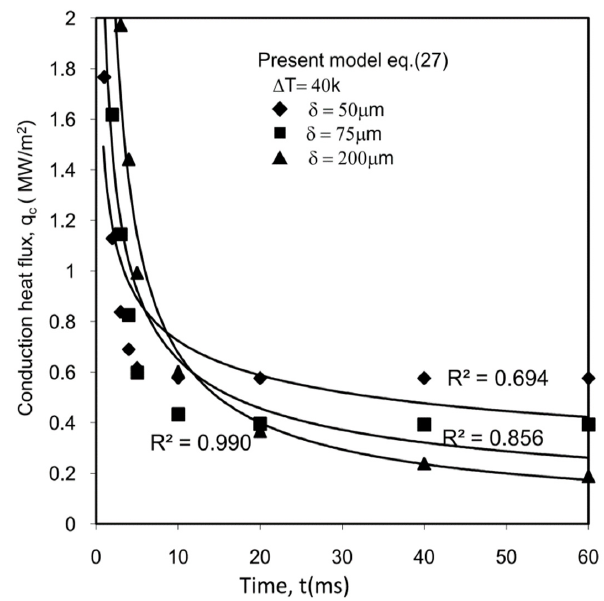
Figure 6. Transient conduction heat fluxes for different macrolayer thicknesses.